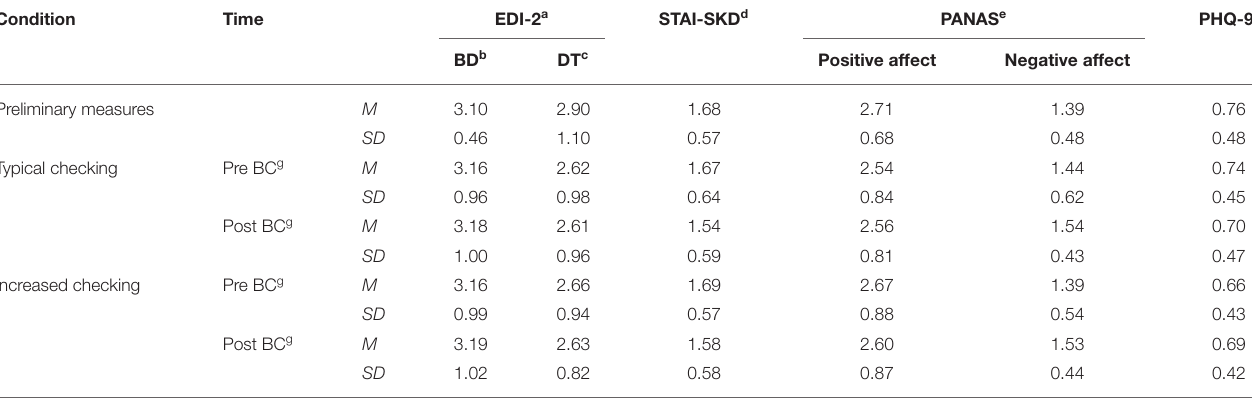
TABLE 3 | Means and standard deviations for the respective conditions. Condition